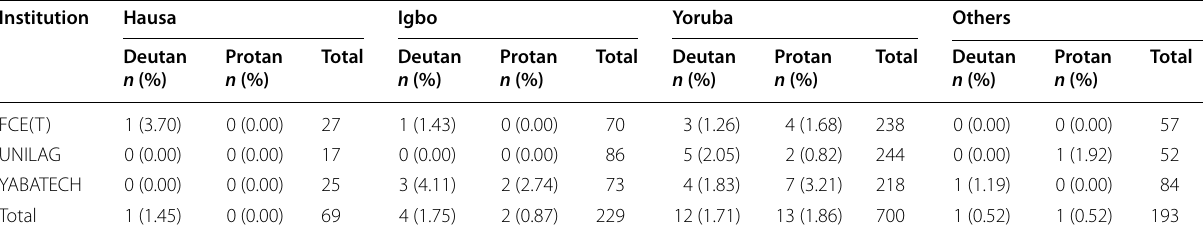
Table 5 Prevalence of different types of colour vision deficiency among different ethnic groups of the students of FCE(T), UNILAG and